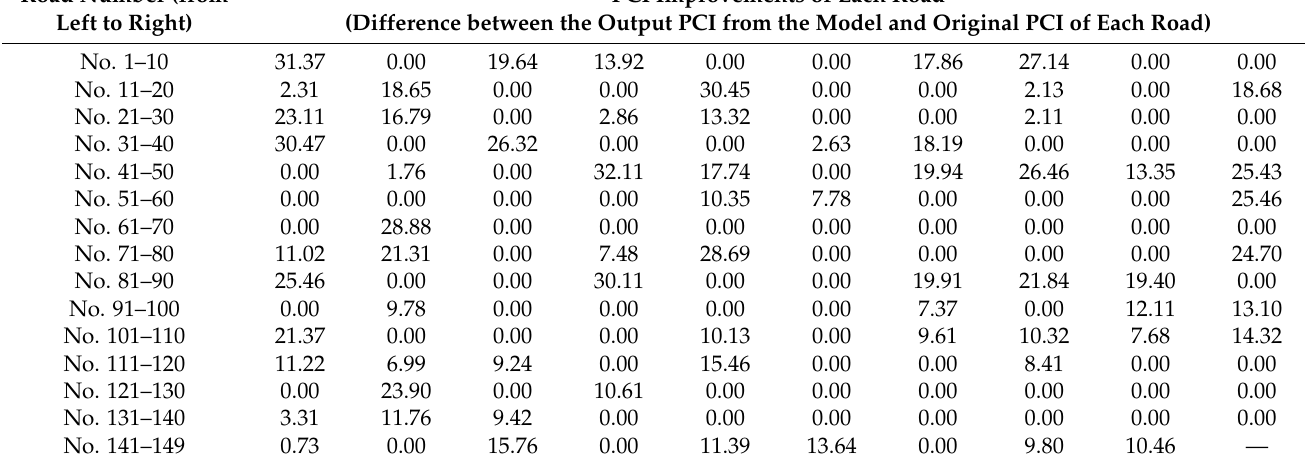
Table 5. PCI improvements of 149 roads according to the optimal scheme obtained by the MMQLB model with a 5 million CNY budget